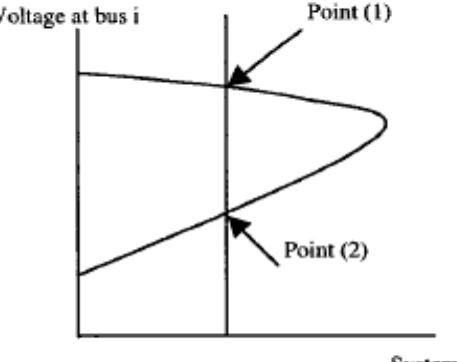
Fig.5. P-V curve for given